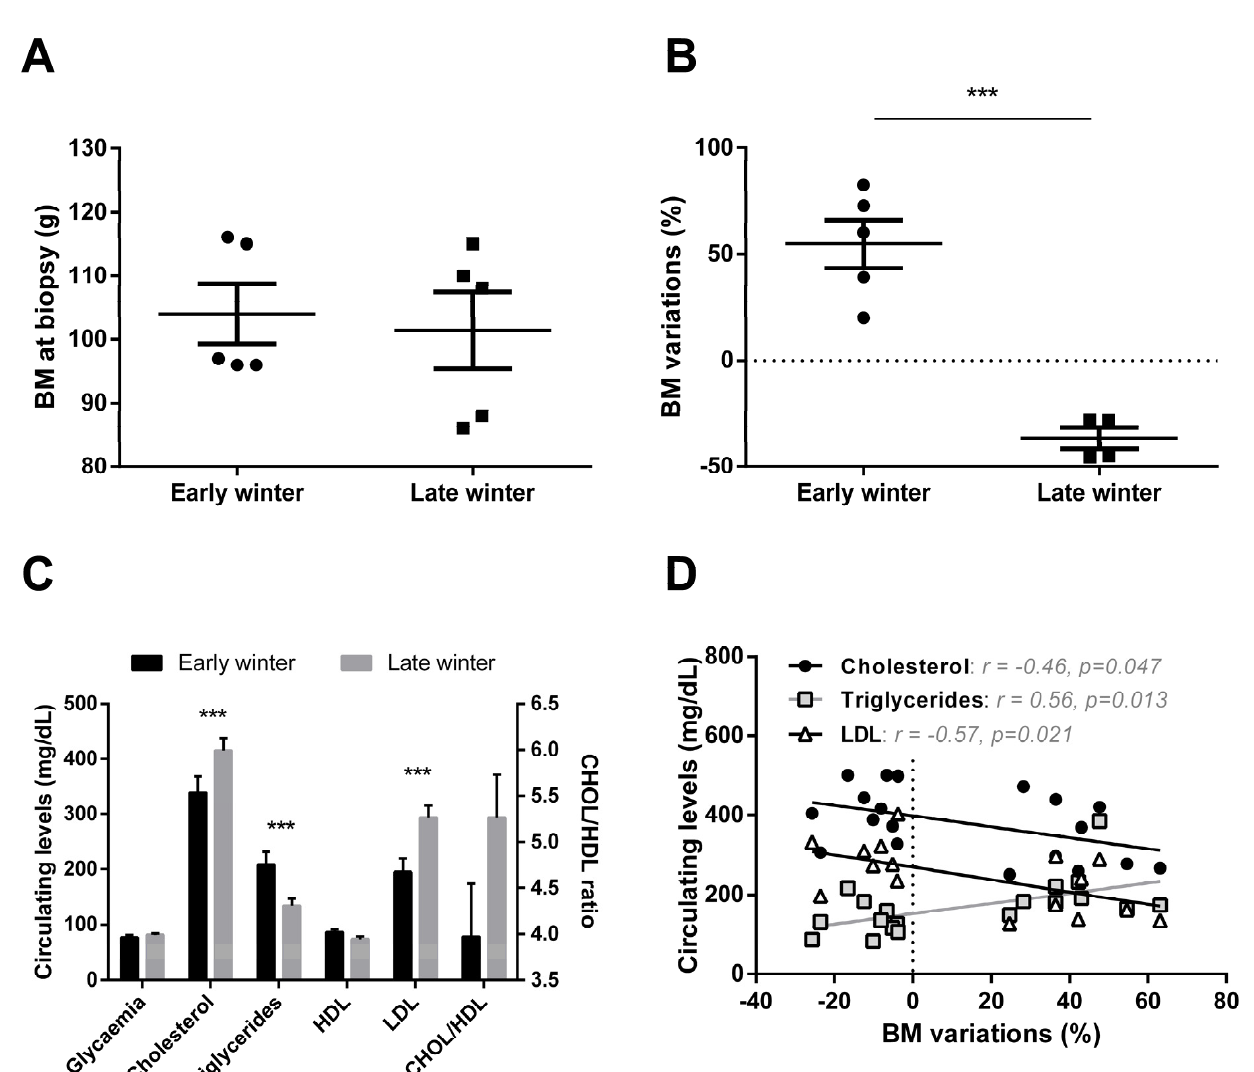
Figure 1. Body mass and plasma profiles in grey mouse lemurs during winter. Although mouse lemurs sampled in early (EW) and late (LW) winter (N = 5/group) exhibited similar body masses (BM) at the time of liver biopsy (panel A ), variations during the first vs the second half of winter clearly showed BM gain in EW but BM loss during LW (panel B ). Changes in BM dynamics were paralleled by changes in plasma metabolites and lipoprotein levels (panel C , data are presented as the means ± SEM), the relationship between these parameters being significant in some cases (panel D ). *** indicate significance at p < 0.0001 between EW and